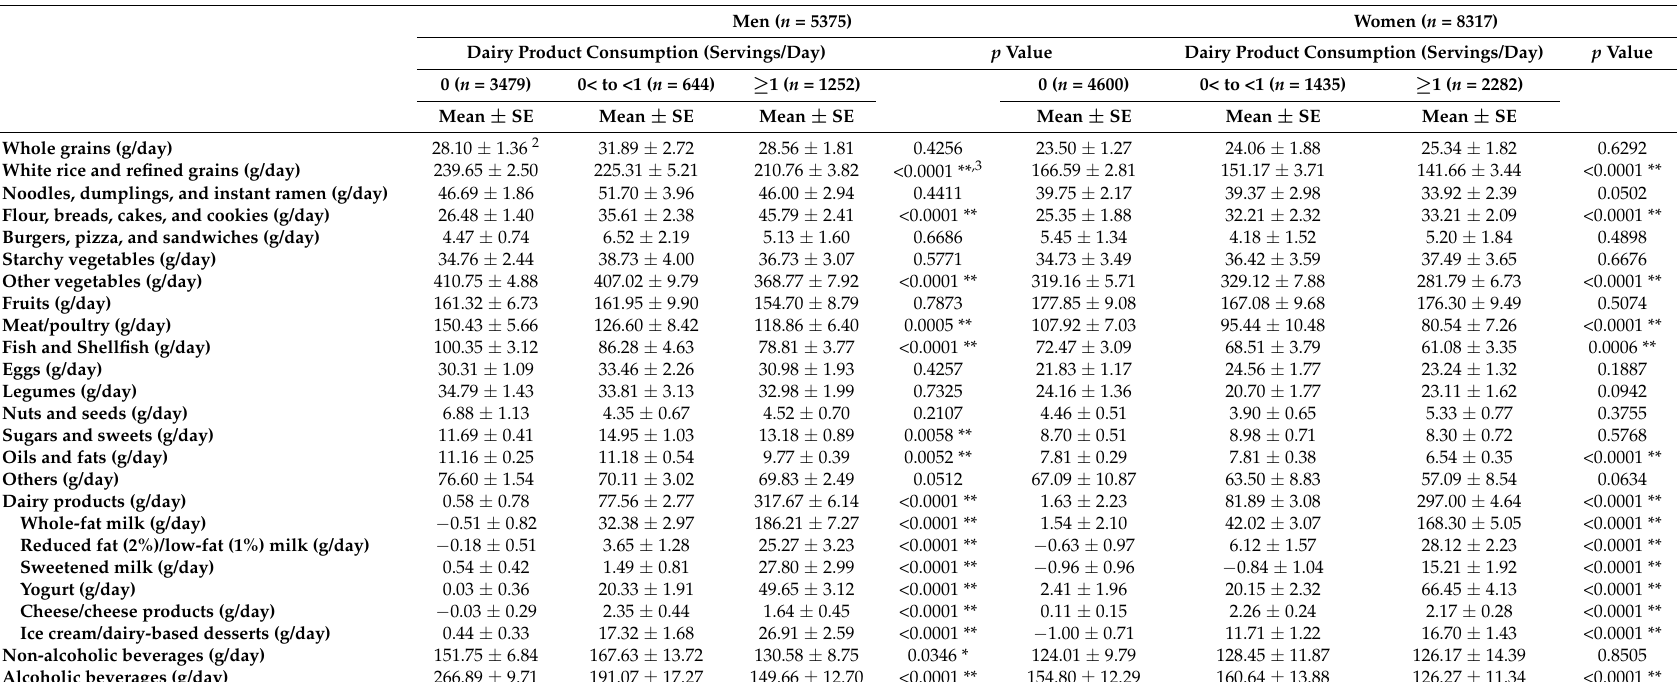
Table 3. Food group intakes according to dairy product consumption in Korean adults, KNHANES 2010–2013 1